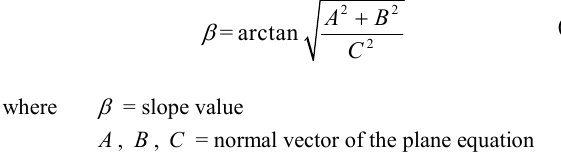
Table 1. The intrinsic parameters of the camera